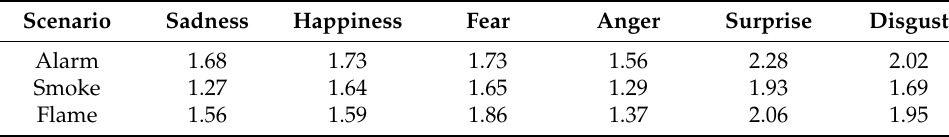
Table 2. Standard deviations of basic emotion shifts.